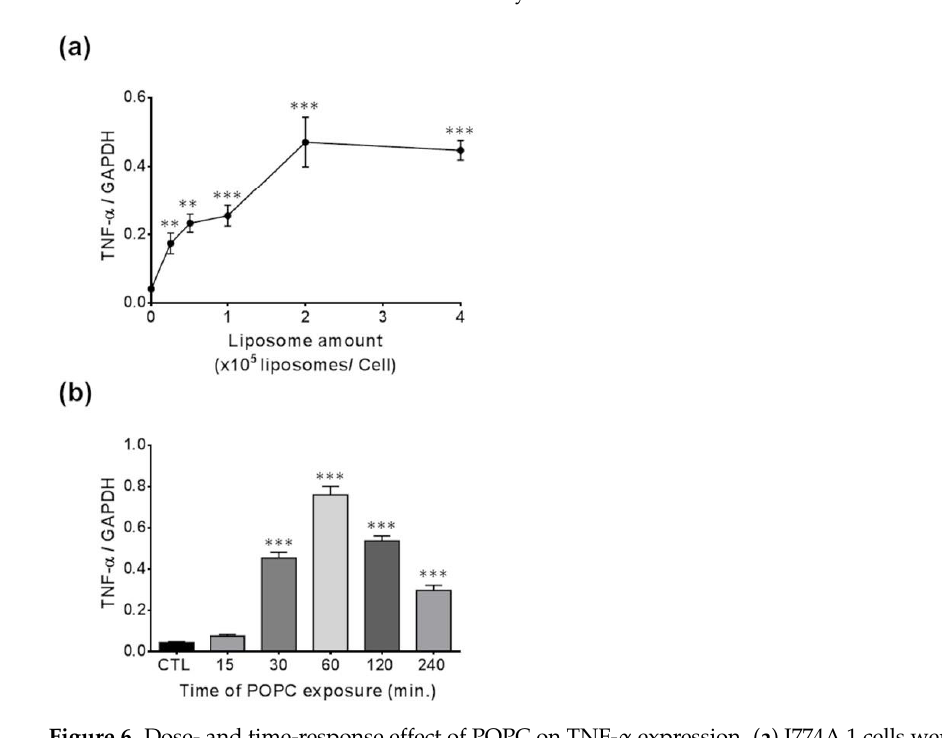
Figure 5 . POPC liposomes are captured by J774A.1 macrophages. ( a ) J774A.1 cells were incubated with POPC liposomes (400 µg) loaded with AlexaFluor647-labeled dextran for either 30 or 60 min. Control cells received PBS vehicle only (no liposome). After incubation, cells were washed twice with FACS staining buffer and fluorescence was analyzed by flow cytometry. ( b ) J774A.1 cells were incubated with POPC liposomes (400 µg) loaded with AlexaFluor488-labeled dextran for either 15, 30, or 60 min. After incubation, cells were washed with PBS, fixed with 4% PFA, and washed again with PBS. Cells were then mounted with Vectashield Antifade Mounting medium containing DAPI for counterstaining. Images were acquired using a Nikon Eclipse TE300 fluorescent microscope equipped with the Zeiss AxioCam HRm camera and analyzed with the Zen 2.6 software.